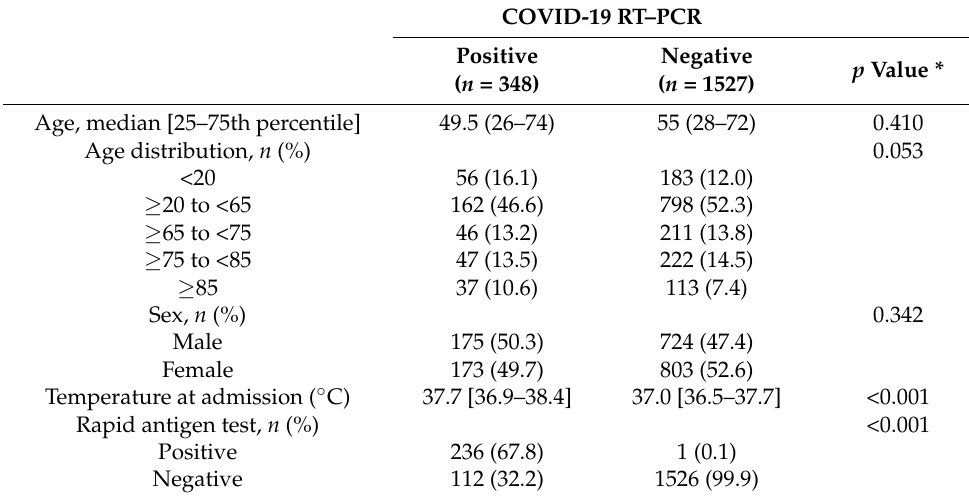
Table 1. Baseline characteristics of the study